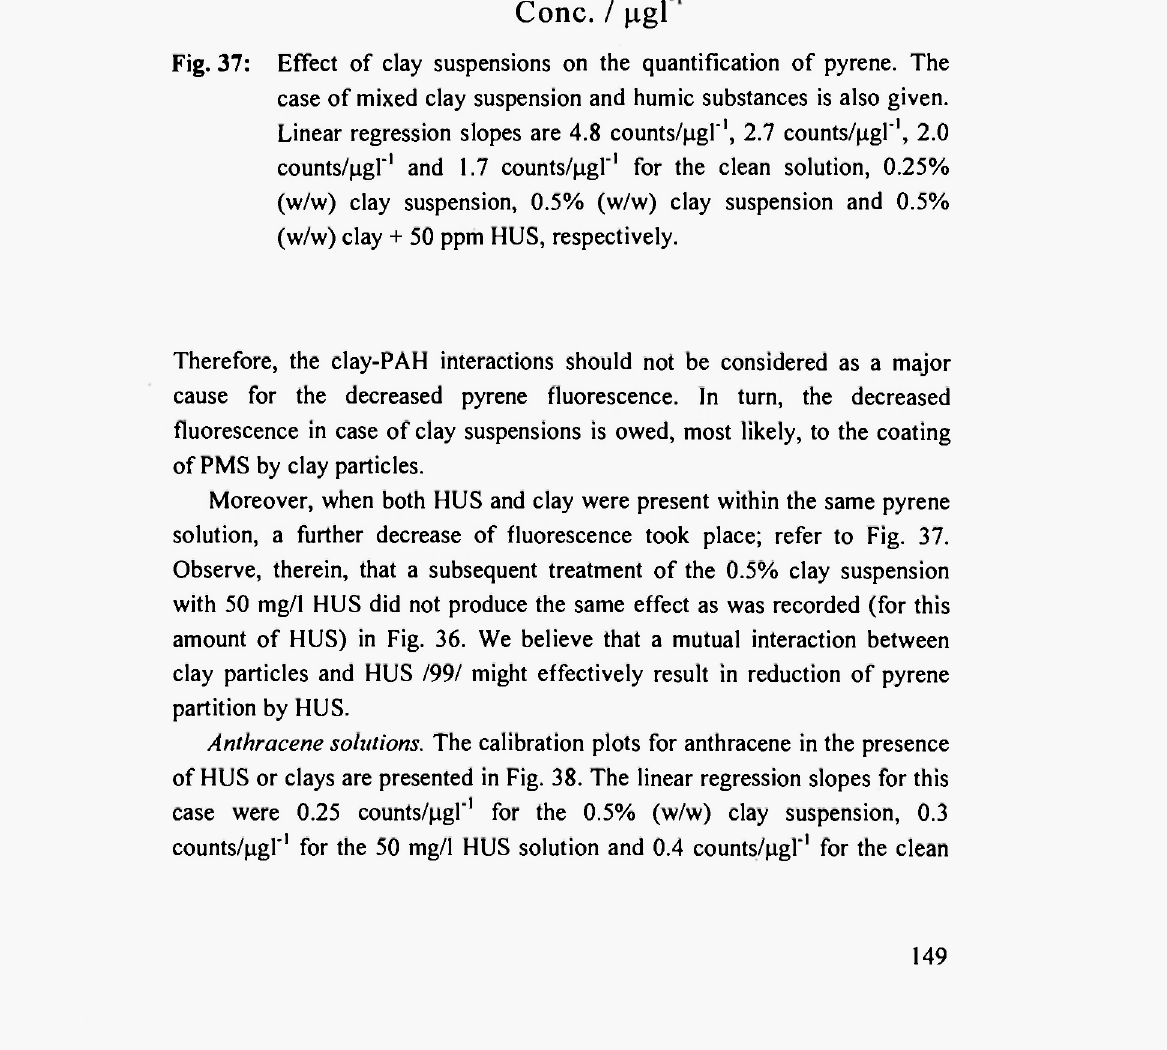
C o n e. / μ βΐ Effect of clay suspensions on the quantification of pyrene. The Fig. 37: case of mixed clay suspension and humic substances is also